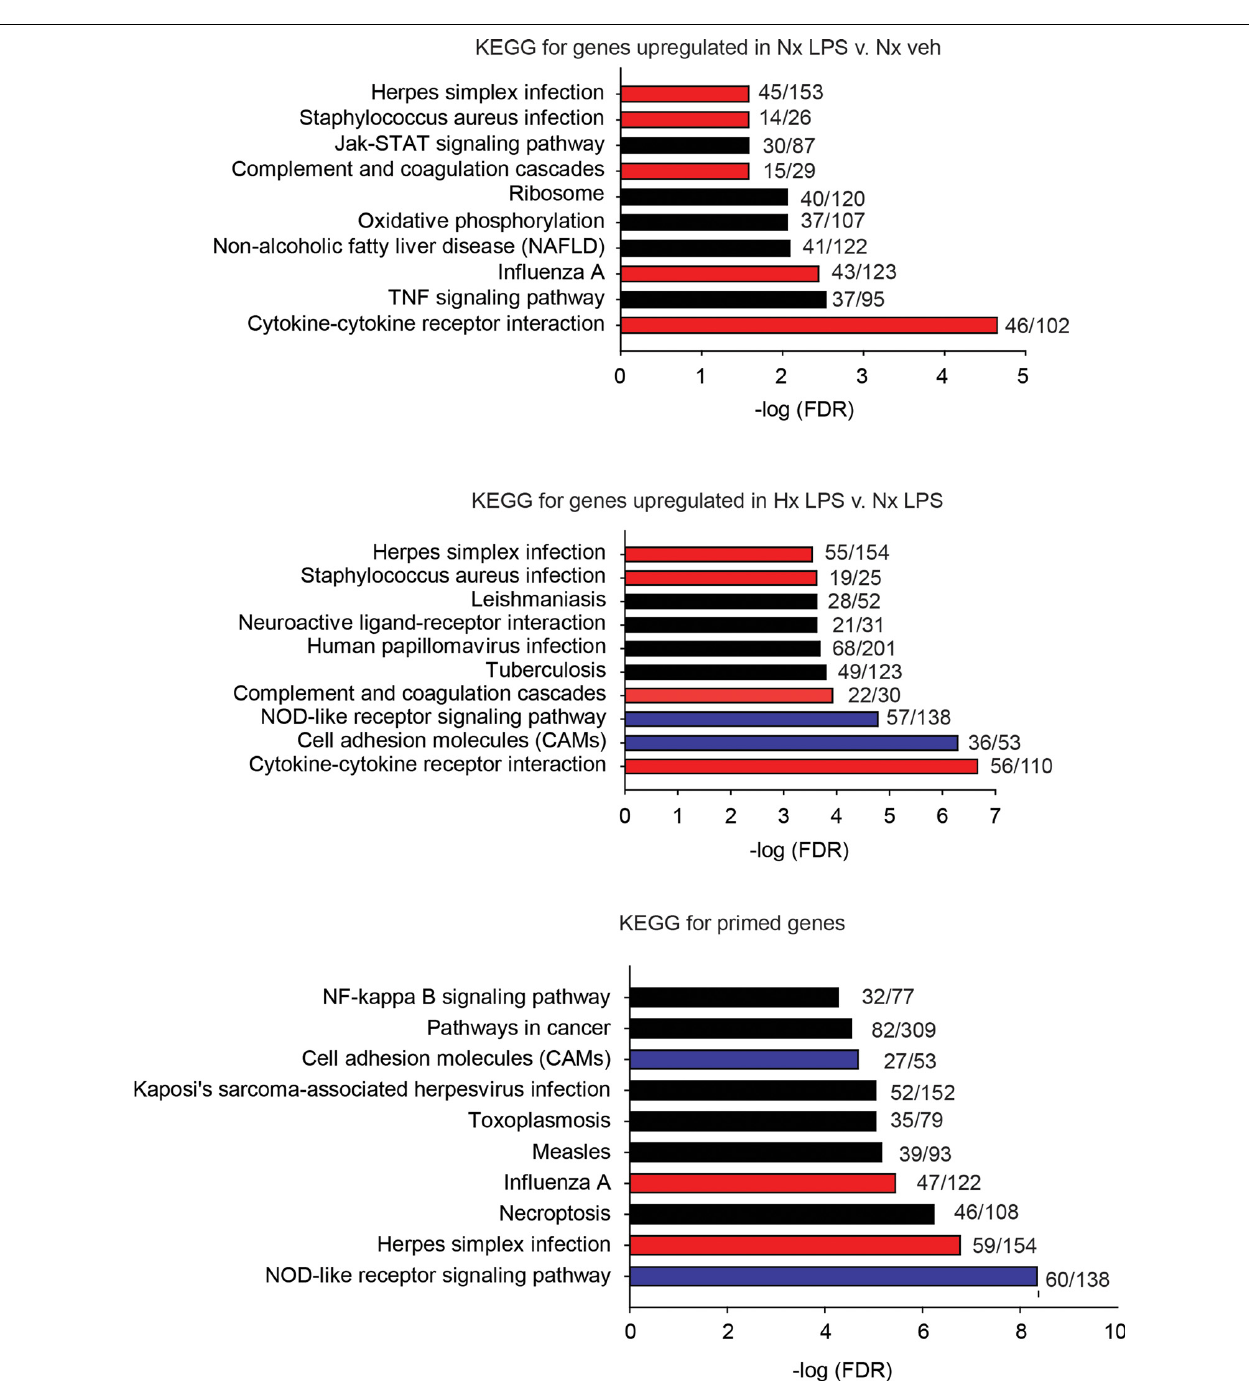
FIGURE 3 | KEGG pathway analyses for all significantly upregulated genes in Nx LPS vs. Nx, Hx LPS vs. Nx LPS, and Primed genes. Each graph displays the top 10 most significant categories. The numbers at the end of each bar are the number of observed/expected genes in each category. Red bars represent LPS-induced gene categories that are shared with Hx LPS-induced and primed gene categories. Blue bars represent Hx-induced gene categories shared with primed gene categories. Black bars represent all unshared categories. Gene expression results are derived from n = 3 biological replicates/treatment.